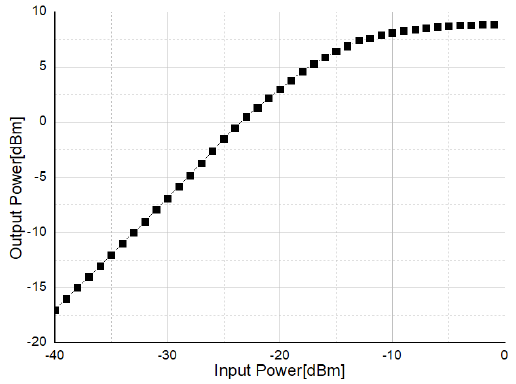
Figure 34. Measurement result of transmitter maximum